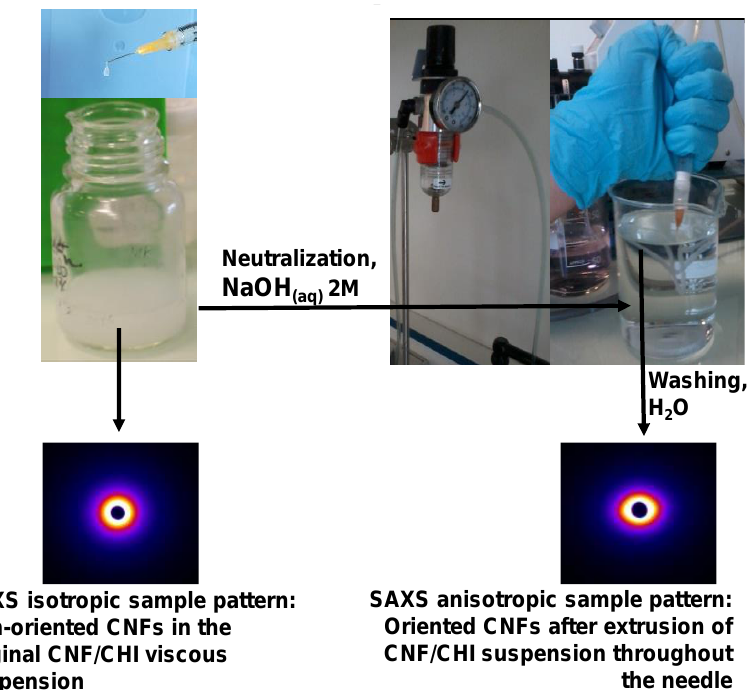
Figure 7. X-ray scattering analyses of the starting CNF/CHI formulation, whose small angle X-ray scattering SAXS pattern corresponds to isotropic behavior; and of the formulation after extrusion through the needle and neutralization, whose SAXS pattern corresponds to anisotropic behavior, revealing the orientation of the CNFs.